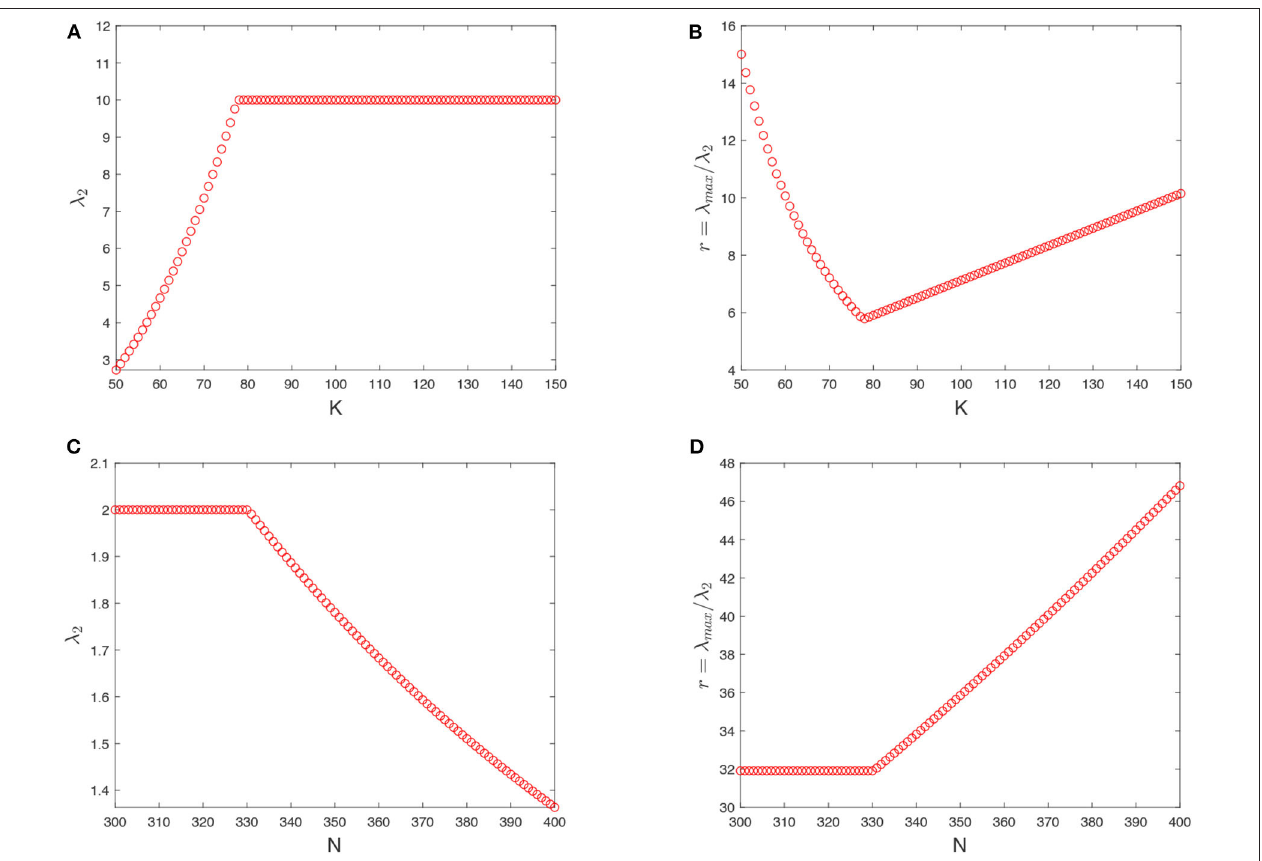
FIGURE 3 | Synchronizability of two-layer K-nearest-neighbor networks. Panels (A,B) display λ 2 and r = λ max /λ 2 vs. the node degree K ( N = 200, d = 5, a = 0.5). Panels (C,D) display λ 2 and r = λ max /λ 2 vs. the network size N ( K = 50, a = d =